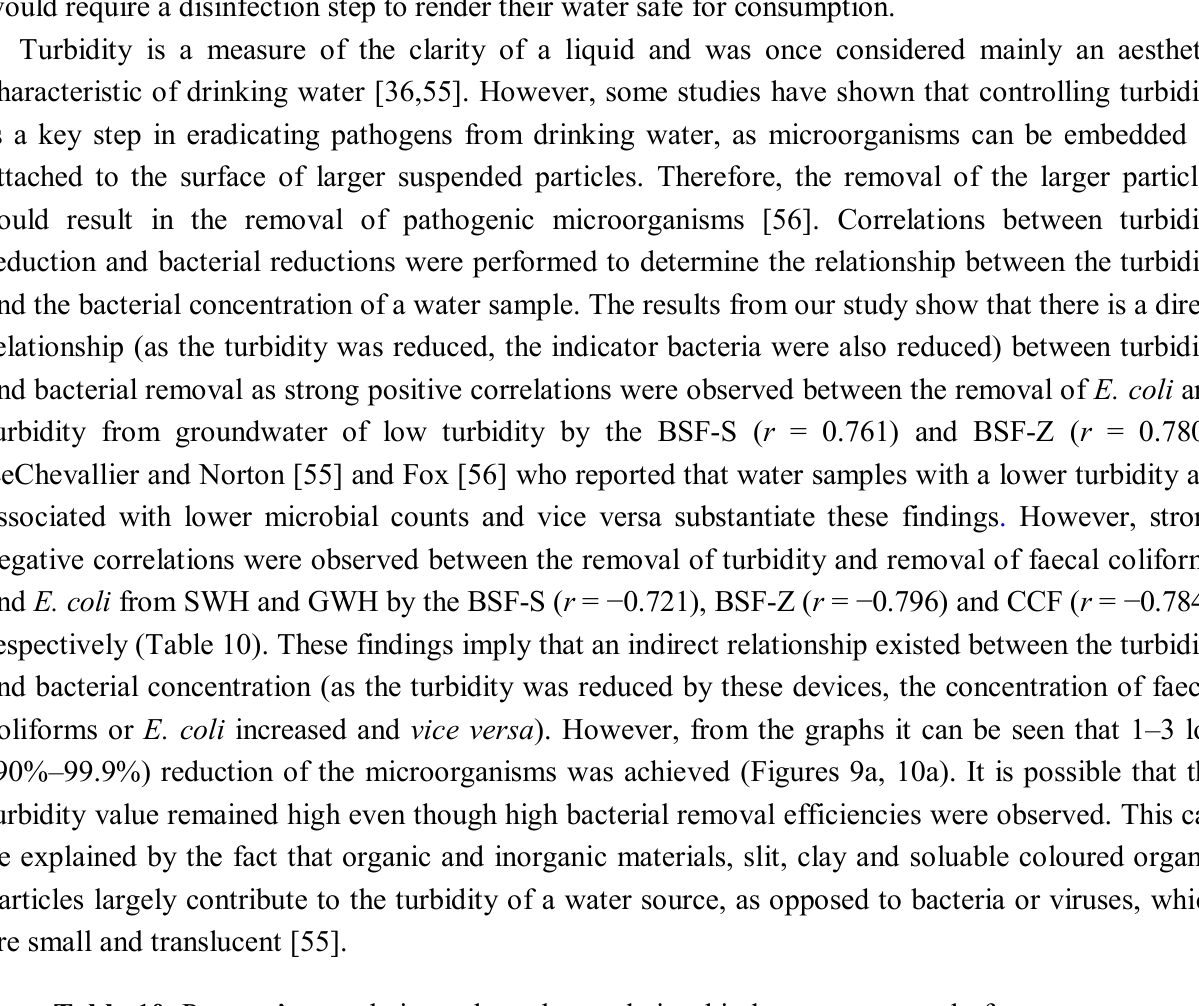
Table 10. Pearson’s correlation values show relationship between removal of source water turbidity and bacterial removal efficiency of HWTS